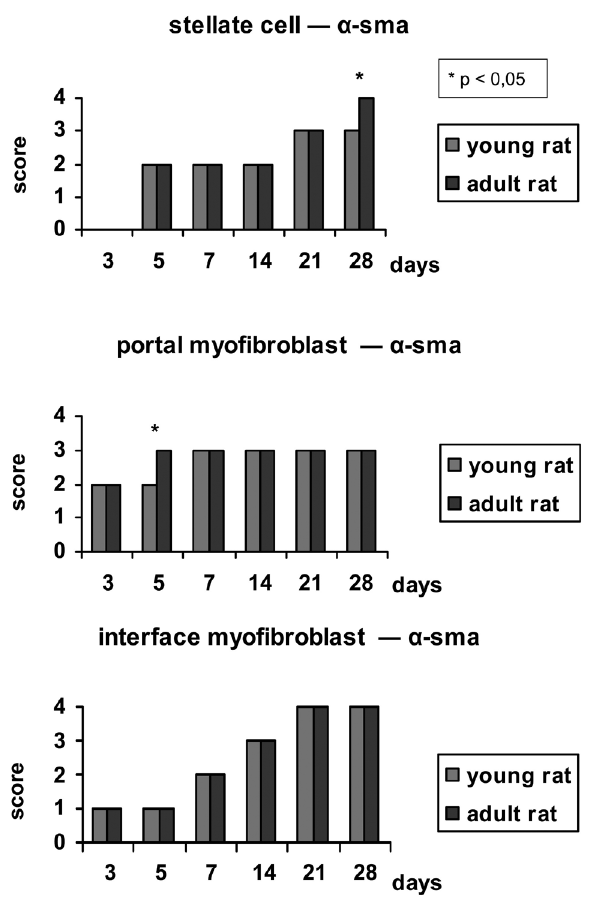
Figure 2 - Bar chart showing the expression of α -SMA at each phase of the experiment in young rats (YR) and adult rats (AR). The values expressed are